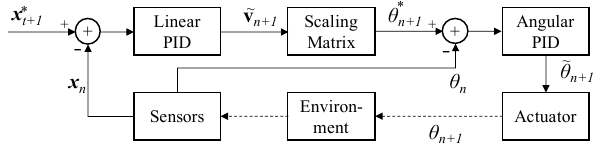
Figure 2. The control system of a quadcopter